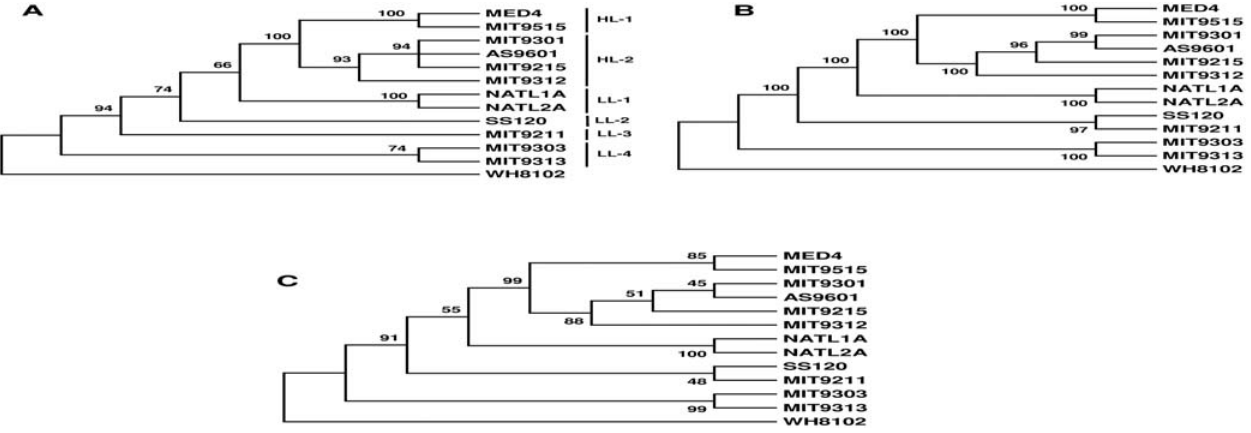
Figure 1. Phylogeny of 12 Prochlorococcus genomes inferred from (A) 16S rRNA, (B) random concatenation of 100 protein sequences sampled from core genome, and (C) concensus tree of all core genes. Trees were reconstructed by neighbor-joining (A), maximum parsimony (B), and maximum parsimony (C) methods. The trees are reprints from Kettler [11]. HL, high light adapted strains; LL, low light adapted